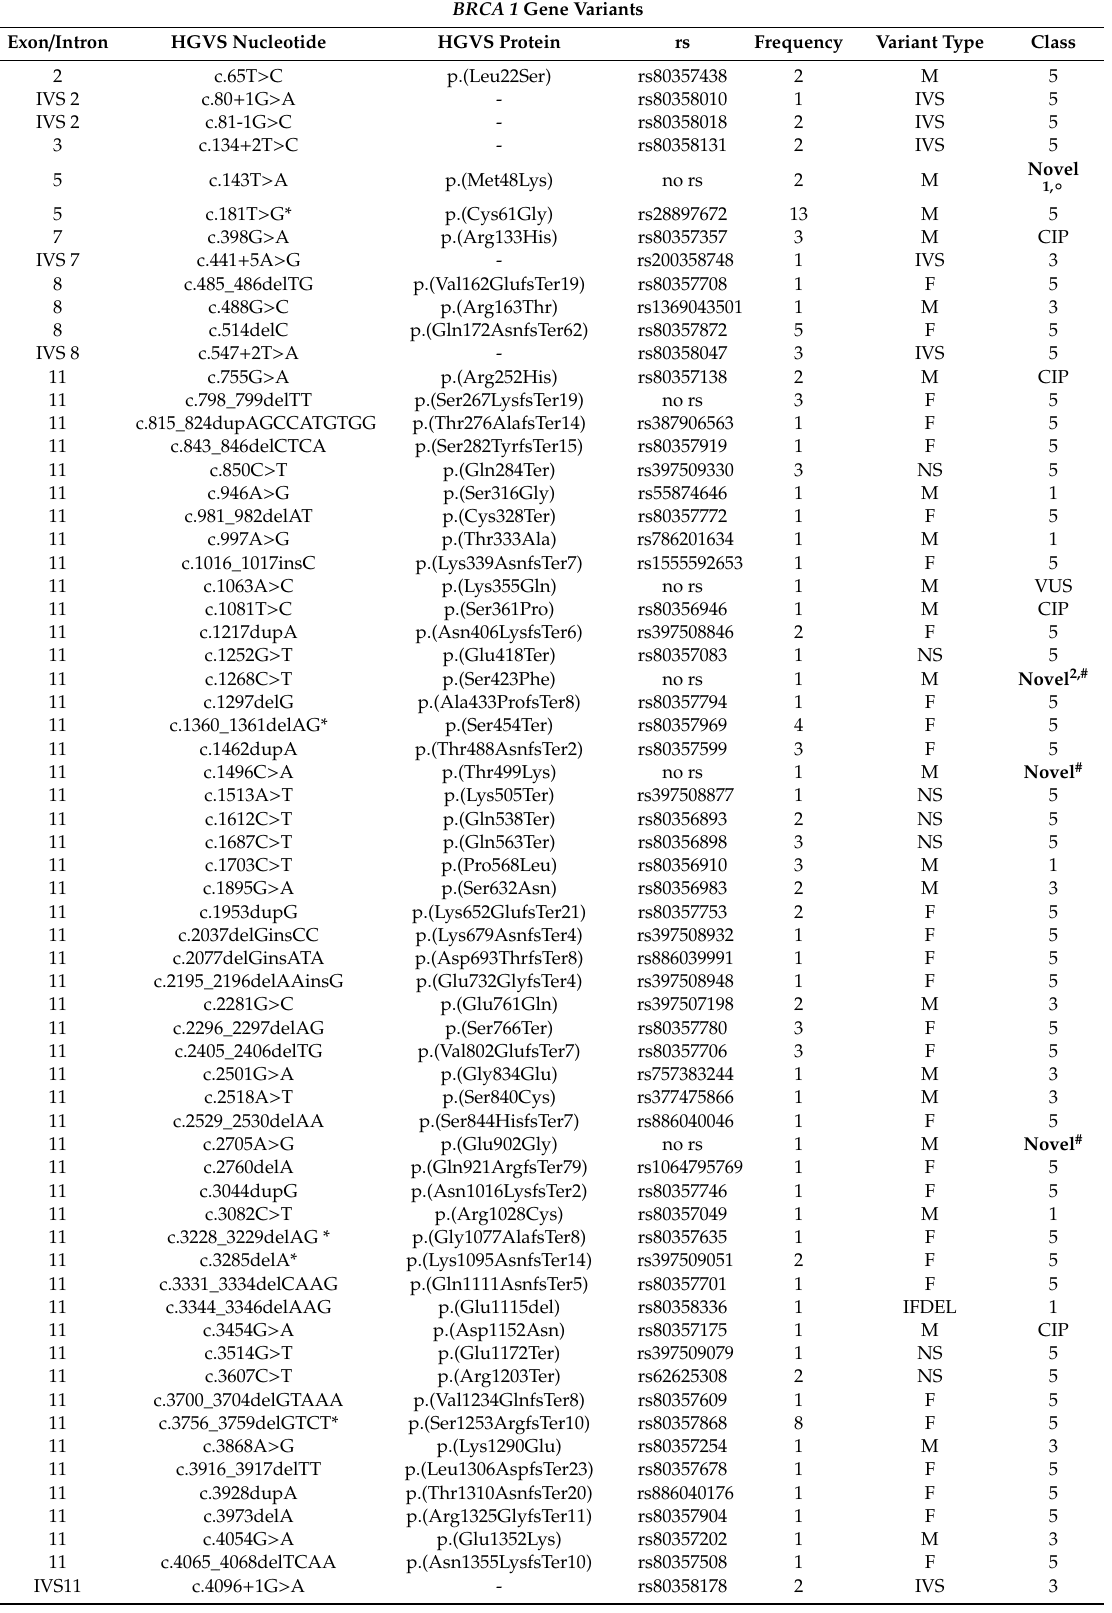
Table 2. Spectrum of germline variants in BRCA1 and BRCA2 genes identified in 517 BC and OC